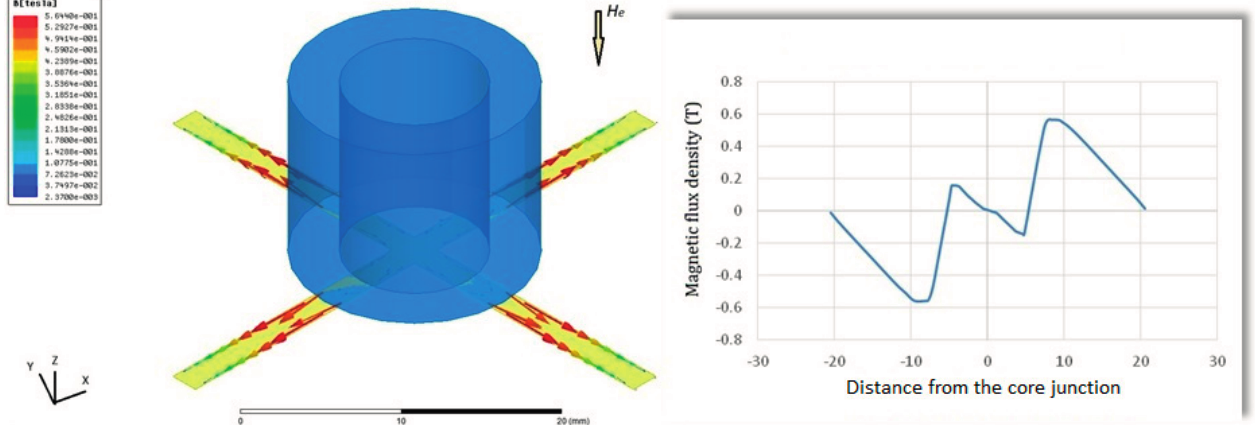
Figure 7. A 3-D modeling and simulation result of a tri-axis planar device with a 2-mm cruciform ferromagnetic core and a fluxguide ( left ); The variation of magnetic flux density along the core is also available and the magnetic fields in Z-axis is 40 A/m ( right